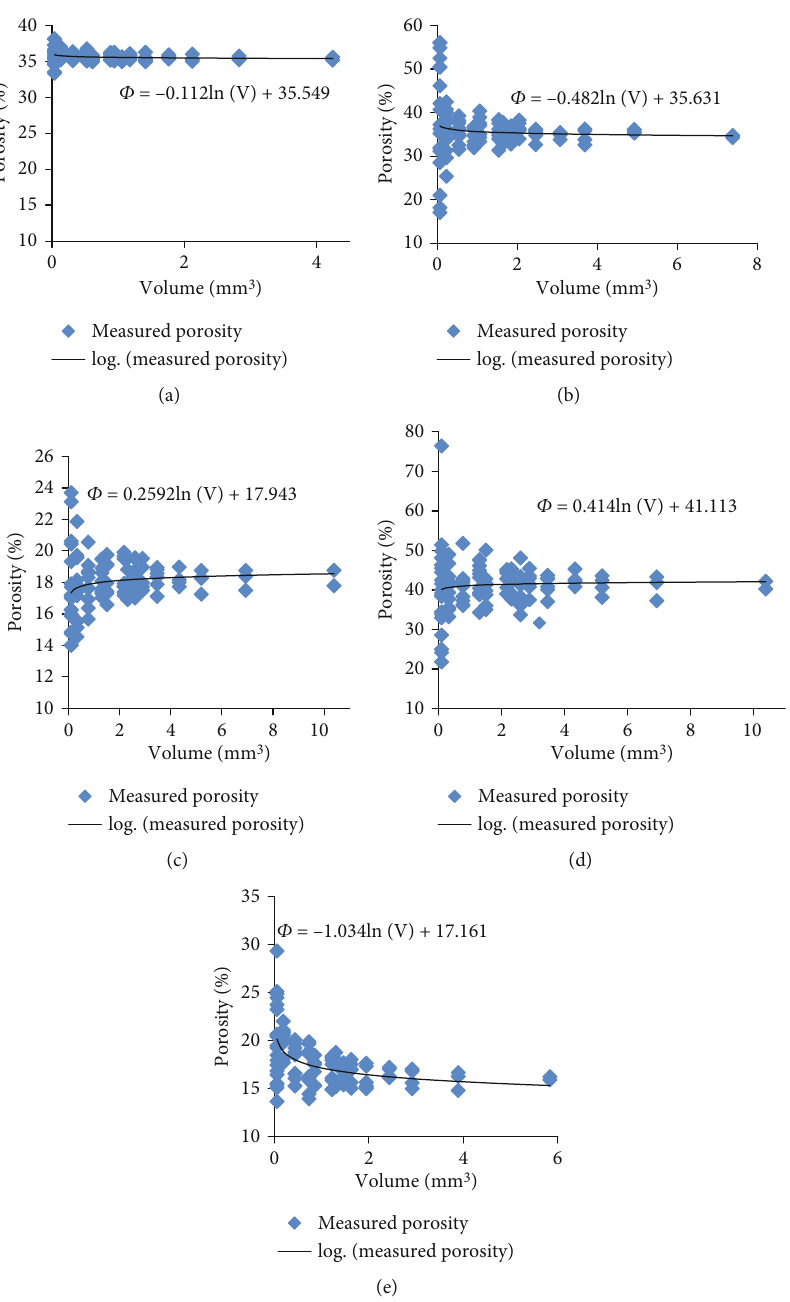
Figure 9: Volume plotted against porosity (%), with a back-transformed regression line. (a) Glass bead pack, (b) sand pack, (c) Bentheimer sandstone, (d) St. Bees sandstone, and (e) Mount Gambier carbonate. Table 11: Sum of relative error of regression obtained from each model fi